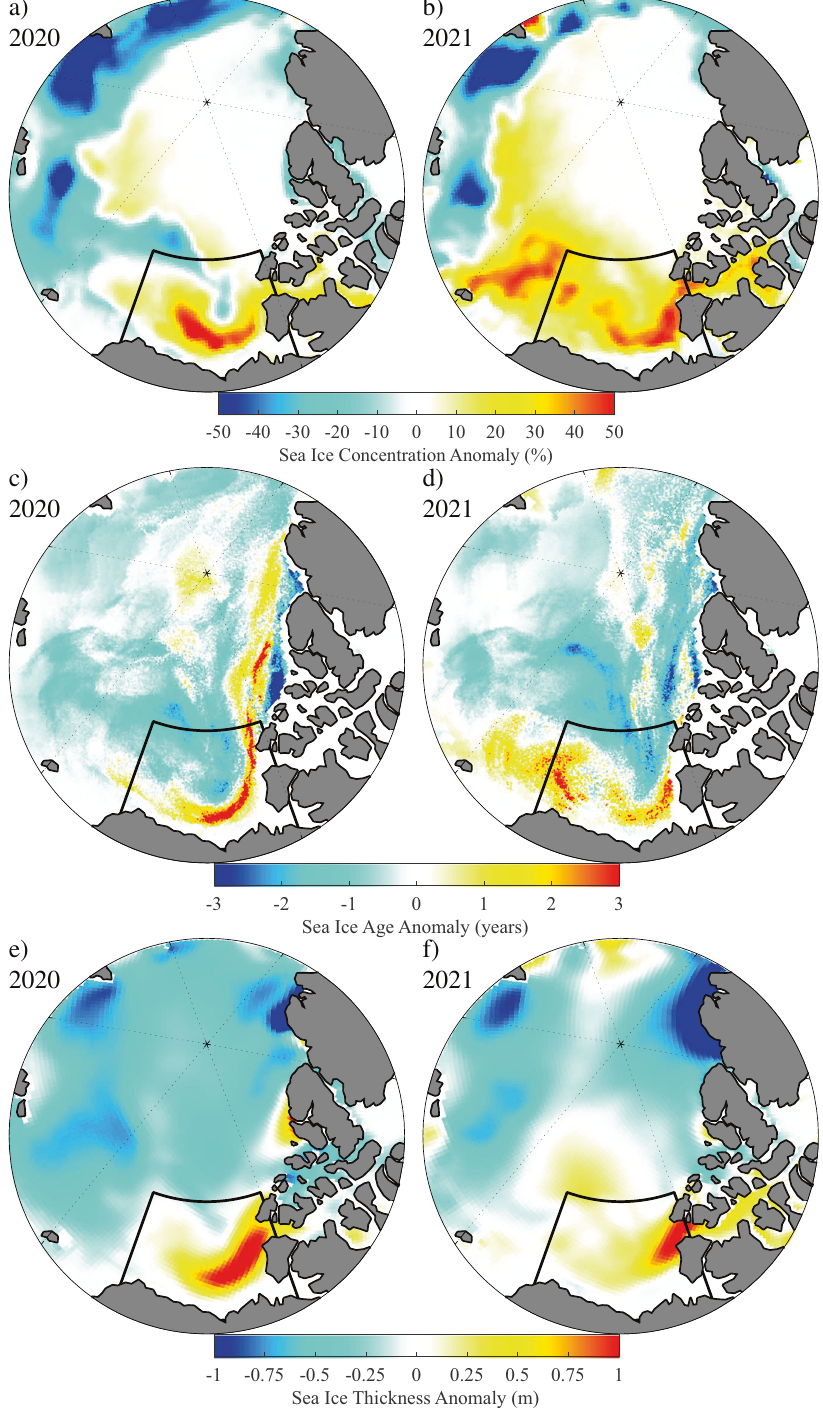
Fig. 1 Recent characteristics of summer (July – September) sea ice in the Western Arctic. Anomalies in the: NSIDC CDR sea ice concentration dataset for: are with respect to 2007 – 2019. The polygon indicates the region along the Beaufort Coast over which statistics were